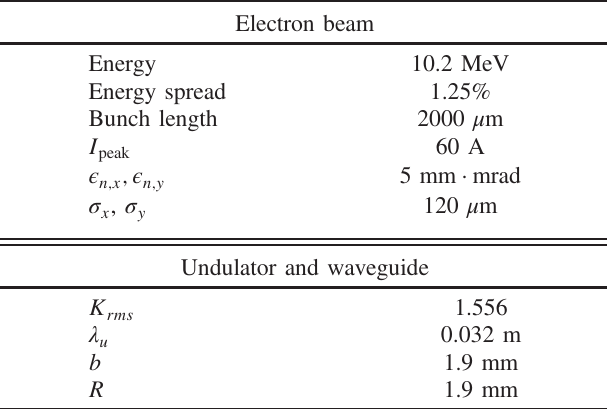
TABLE II. Parameters for high efficiency THz